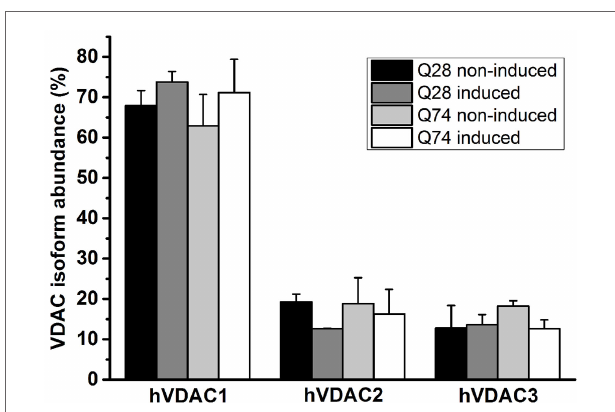
FigUre 3 | Quantitation of VDac isoforms in VDac preparations isolated from Pc12 hD-Q23 and Pc12 hD-Q74 cells . The quantitation was based on emPAI. The data are presented as mean values ± SD of three independent experiments. Q23 non-induced and Q74 non-induced denote PC12 HD-Q23 and PC12 HD-Q74 cells cultured for 48 h without expression of Htt and mHtt, respectively, whereas Q23 induced and Q74 induced denote the cells with the proper expression lasted for 48